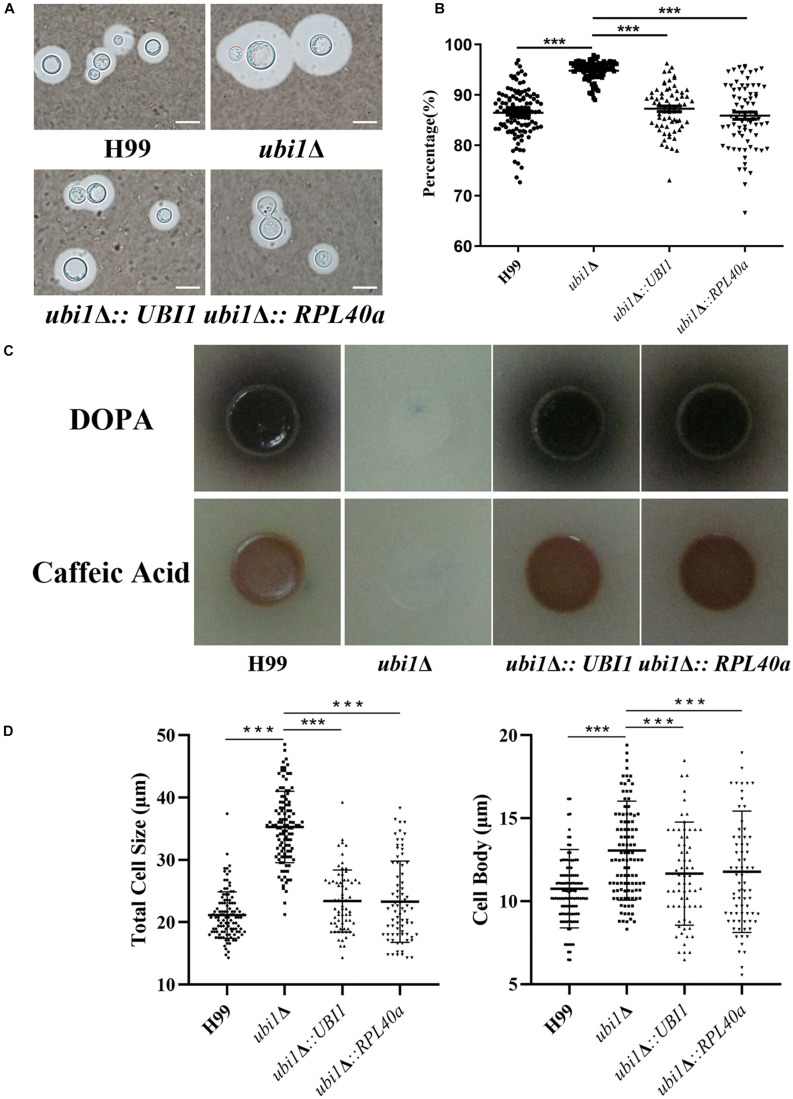
Ubi1 is involved in the production of capsule and melanin in C. neoformans. (A) Capsule induction assay. All the strains were cultured on DME medium at 37°C for 5 days. The capsules were examined by staining them with India ink and visualizing them at 100× magnification (scale bar = 5 μm). (B) Relative capsule volume detection. Total (cell and capsule) and cell-only diameter were measured via Adobe Photoshop Software for more than 50 cells of each strain. Then, the relative ratio of the capsule was calculated with the formula: (Total Volume-Packed Volume)/Total Volume. (C) Melanin production assay. Strains were grown on L-DOPA or caffeic-acid medium for 5 days at 30°C. (D) Titan-like cell induction assay. Strains were grown on Titan Cells Medium at 37°C and 5% CO2 for 3 days. Measurements of total cell sizes (left) and cell body sizes (right). ***P < 0.001.